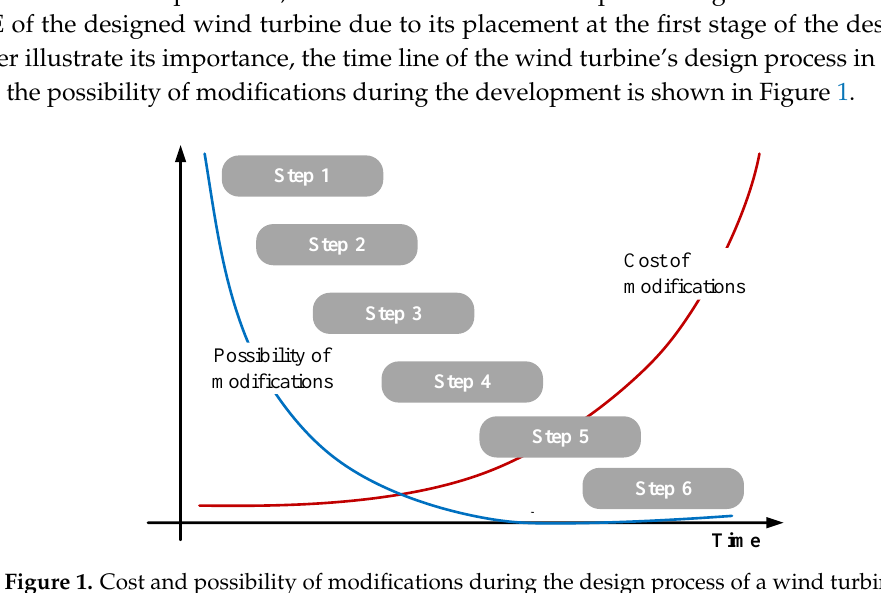
Figure 1. Cost and possibility of modifications during the design process of a wind turbines.